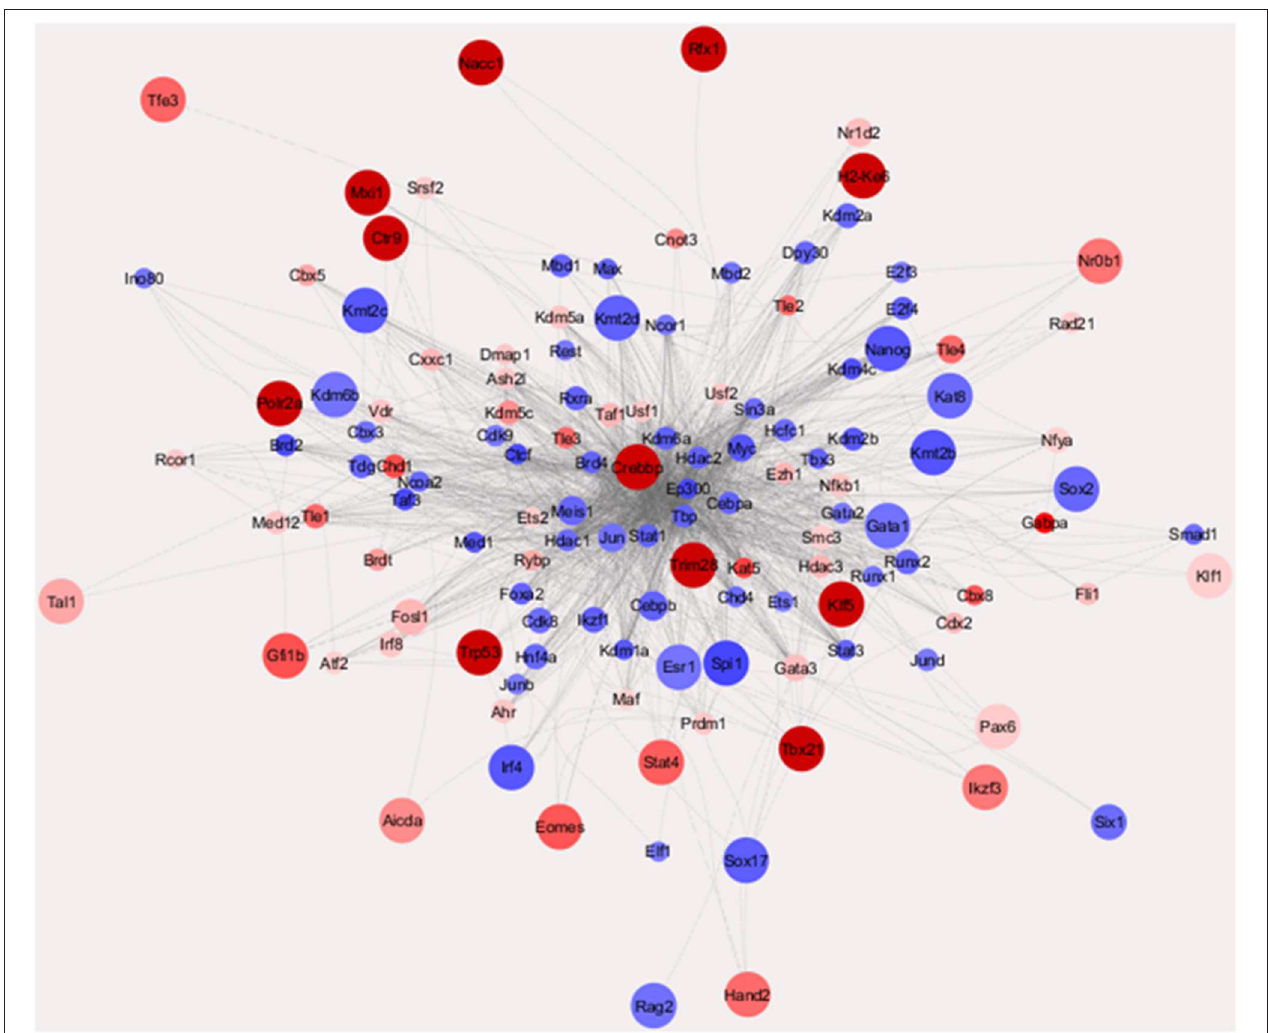
FIGURE 2 | Transcriptional regulatory network of TFs characterizing IPMN and PanIN (Enrichment Score > 10 or < − 10). Those nodes with more out-degrees [the number of other transcription factor (TFs) that they regulate] were placed in a center position. The node size indicated the LogFC value of the TF gene found in cap analysis of gene expression (CAGE) data and the node colors indicate the enrichment scores of the TFs estimated with weighted parametric gene set analysis